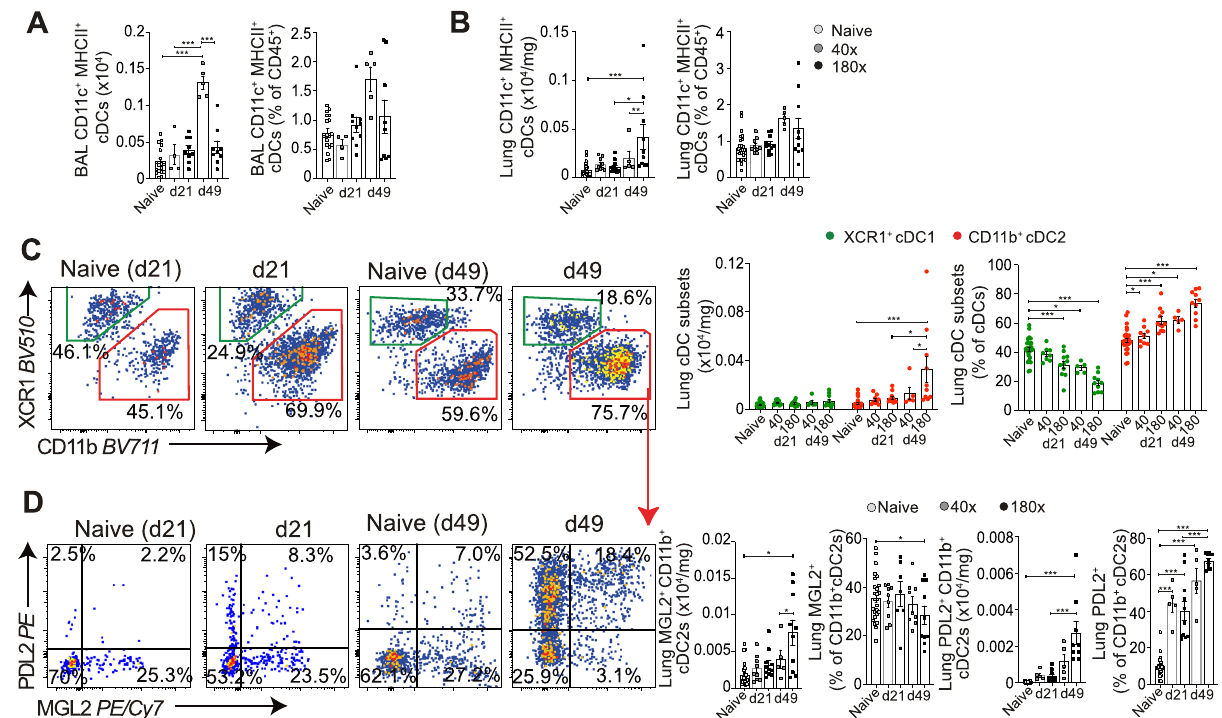
Fig. 5 | Expansion of pulmonary cDC2s in pre-patent and patent murine schistosomeinfection. C57BL/6micewerepercutaneouslyinfectedwith40or180 cercariae, and samples taken at d21 and d49. Total cDCs (CD11c + MHCII + ) were assessedin( A )BALand( B )lungcellisolates. C Representative fl owcytometryplots show cDC subsets (XCR1 + cDC1 and CD11b + cDC2). Gate frequencies show % of MHCII + CD11c + cDCs. D Representative fl ow cytometry plots show changes in cDC2s. Gate frequencies show % of CD11b + cDC2s. Double-positive (MGL2 + PDL2 + )